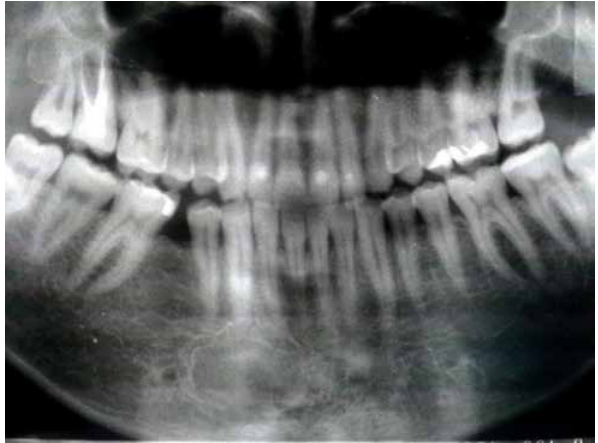
Figure 1: Patient A.R., age 32. Panoramic radiograph. Osteolytic focus in body of mandible in the region of teeth 41 – 44. Lesion has osteosclerotic borders with an irregular, wave-like margin.